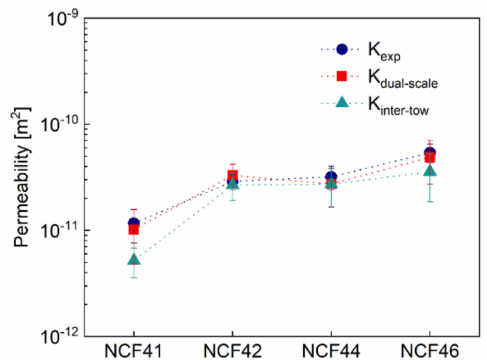
Figure 12. Comparison of the permeability values derived from experimental tests, prediction values considering dual-scale flow and prediction values considering only inter-tow